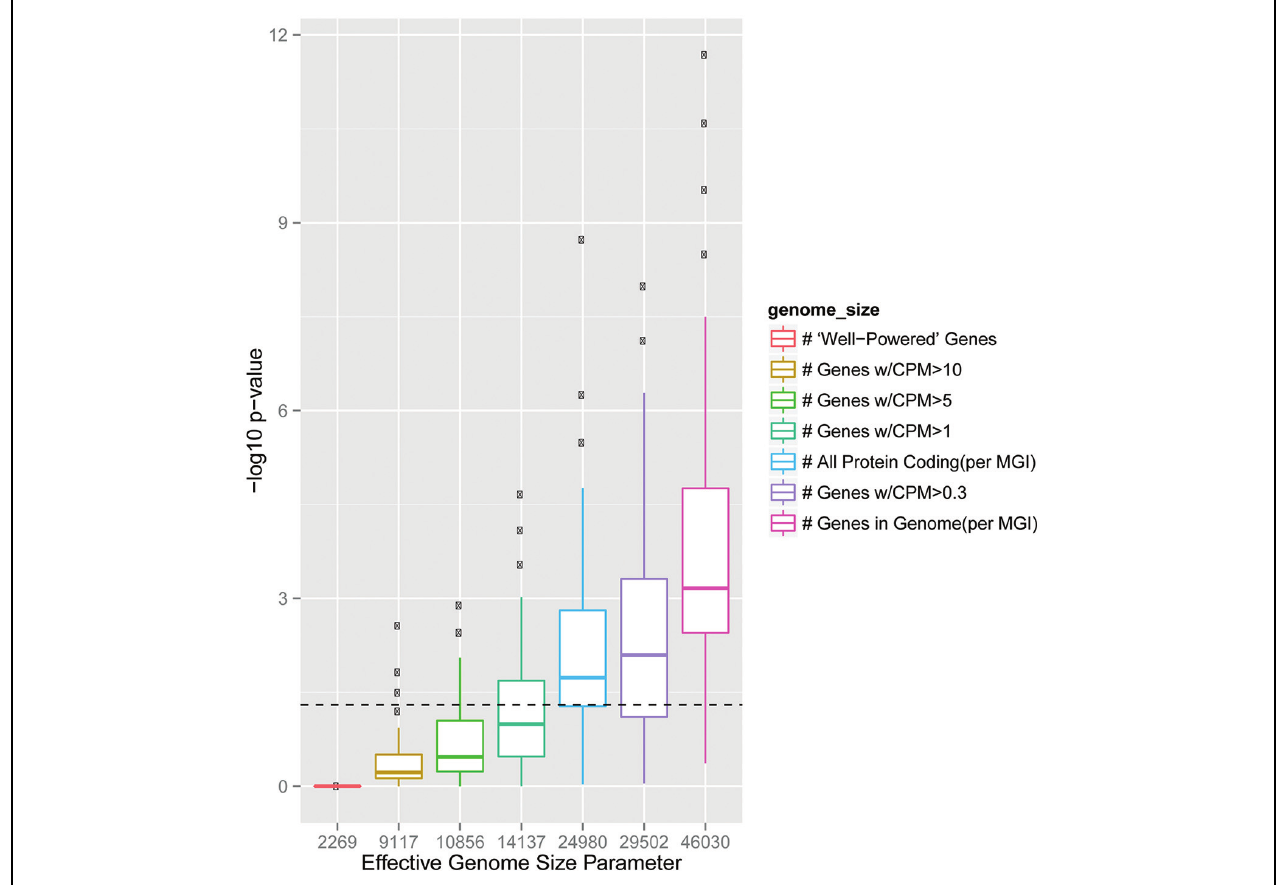
FIGURE 2 | Choice of effective genome size in GO analysis of transcriptomic data can substantially influence statistical results. Boxplots show distribution of − Log10 p-values for Fisher’s Exact Test overlapping the GO:007268, Synaptic transmission, with 100 different sampled lists at each effective genome size indicated. Dashed line is p = 0.05 Power to detect differential expression in RNAseq is influenced by total count number for a particular gene, and thus longer or higher expressed transcripts in a tissue are more likely to be found as significantly different (Bullard et al., 2010; Young et al., 2010). To determine if this could create spurious GO results from a brain transcriptomic experiment, we randomly sampled genes from the 10% most robustly detected genes in a brain RNAseq experiment (Ouwenga and Dougherty, 2015) to mimic results a 100 hypothetical differential expression experiments. If it was assumed these genes were randomly drawn without bias from the whole genome ( n = 46030 genes) this consistently resulted in a statistically significant, but scientifically meaningless, enrichment in the GO category 0007268 (Synaptic Transmission). More conservative estimates which only include genes at least lowly expressed in the brain (CPM > 0.3 or CPM > 1) still frequently yield spurious overlap ( blue, purple ). Because of this, using an effective genome or ‘background gene set’ based on the transcripts which are well-powered for differential expression is